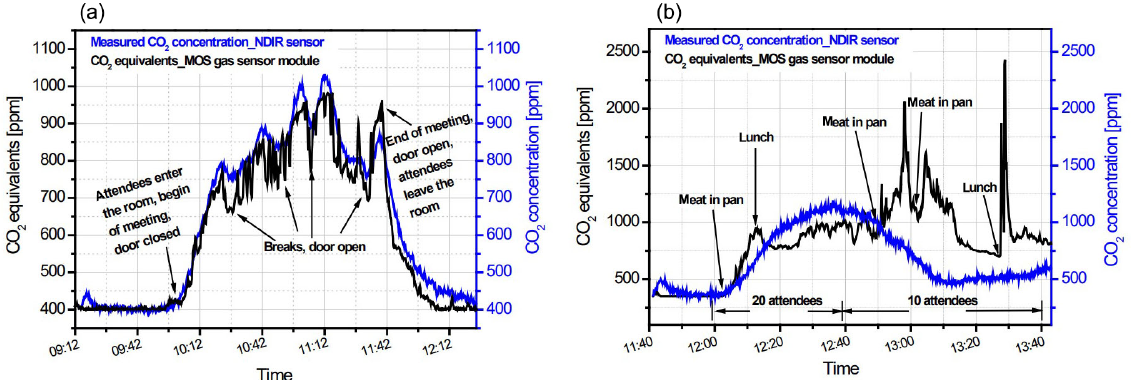
Figure 14. The graphics compares the real CO 2 measurements vs. CO 2 equivalents from t VOC of a previous study. Real CO 2 (in blue) and CO 2 equivalent from t VOC (in black) in a meeting room (a) and kitchen (b) . Source: Ulmer and Herberger